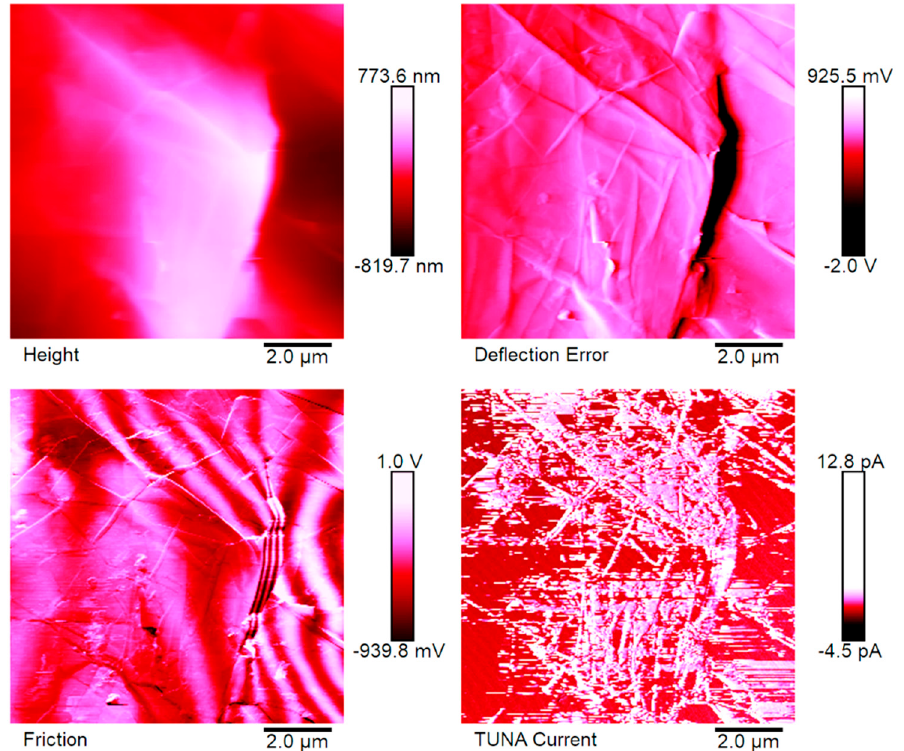
Figure 7. TUNA pictures of the R1%G-py fracture surface.